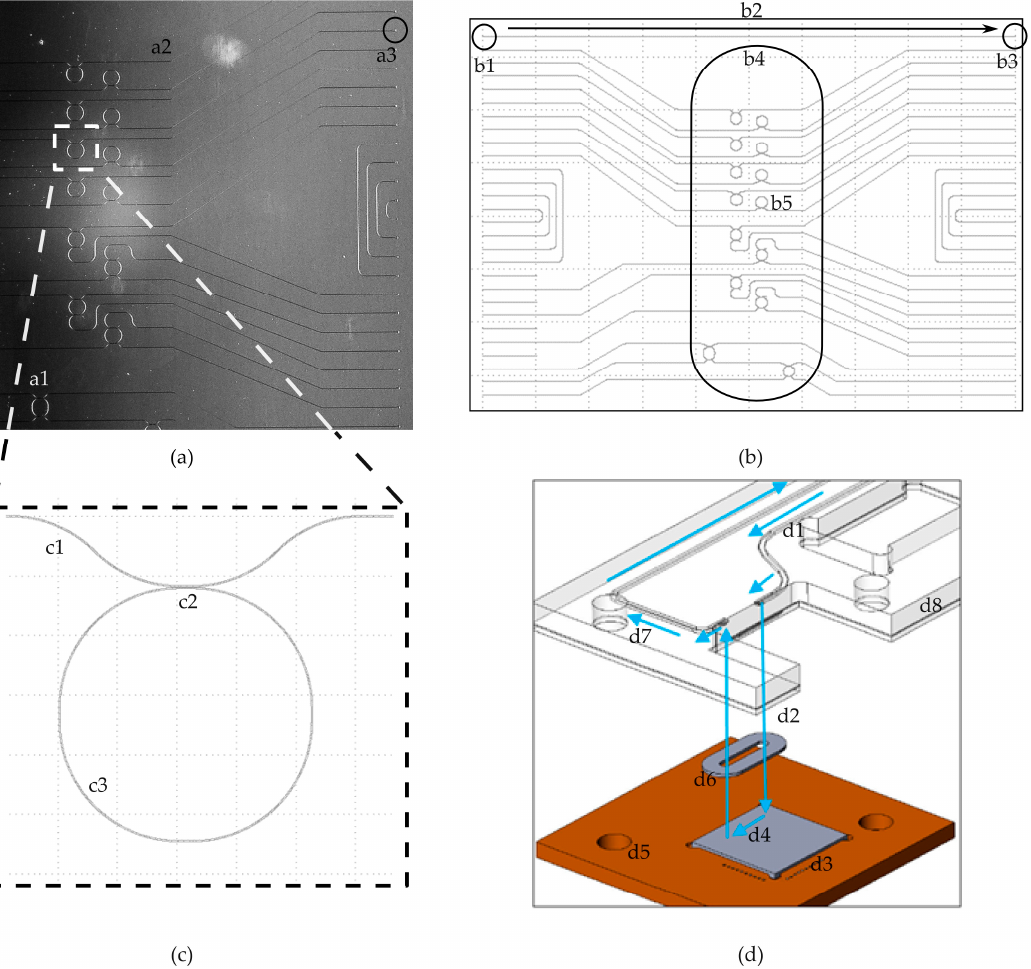
Figure 4. Design of the photonic sensor: ( a ) microscope image of a part of the photonic sensor with optical ring resonators (a1), optical waveguides (a2), and optical interfaces on the right (a3); ( b ) drawing of the whole circuit’s layout with an array of optical grating couplers on the left (b1) and on the right (b3) connected by a waveguide (b2). Optical ring resonators are located in the middle of the chip (b5). The black frame (b4) is not a part of the chip. It marks the area where the liquids will be pumped through; ( c ) detailed design of an optical ring resonator within the photonic sensor. An optical waveguide (c1) passes the optical ring resonator (c3) at a small area (c2); and ( d ) a schematic sketch of the fluidic connection of a polymer based cartridge (d8) and a silicon chip d4 using an elastomer sealing ring (d6). The direction of the pumped liquids is visualized by arrows.